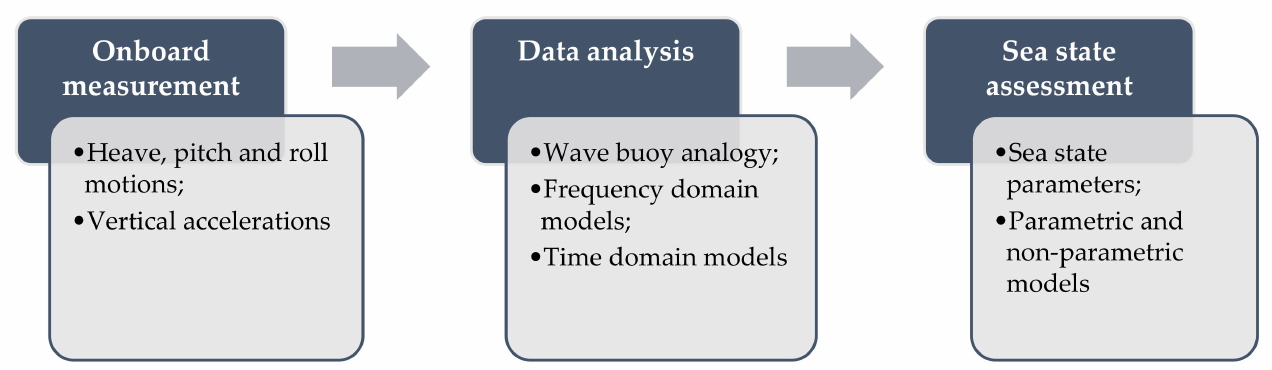
Figure 9. Typical flow chart of sea state onboard measurements.